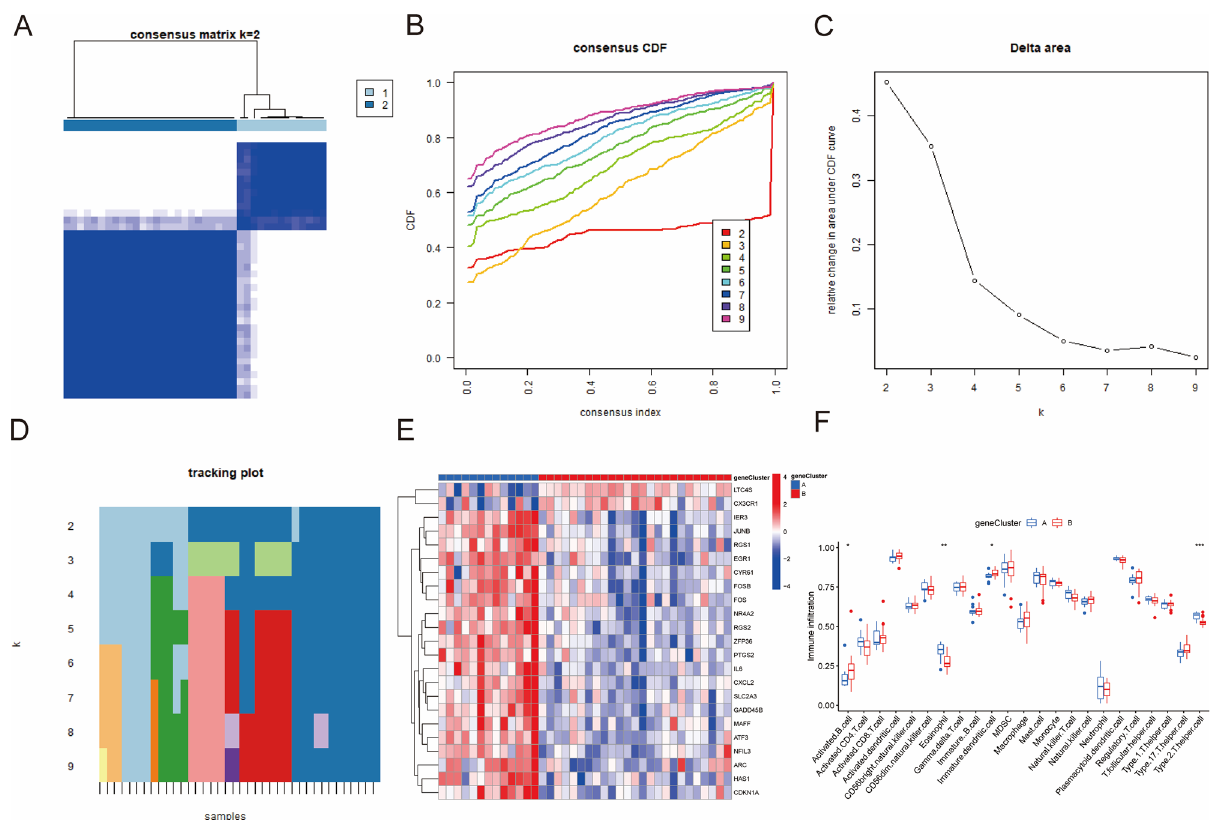
Figure 5. Clarification of two senescence gene clusters. ( A – D ) Clustering of OA synovial samples based on DEGs of the two senescence clusters. ( E ) Heatmap showing expression of DEGs in the two gene clusters. ( F ) Immune cell infiltration in the two gene clusters. (All figures *represents p < 0.05, **represents p < 0.01, ***represents p < 0.001) OA, osteoarthritis; DEGs, differentially expressed